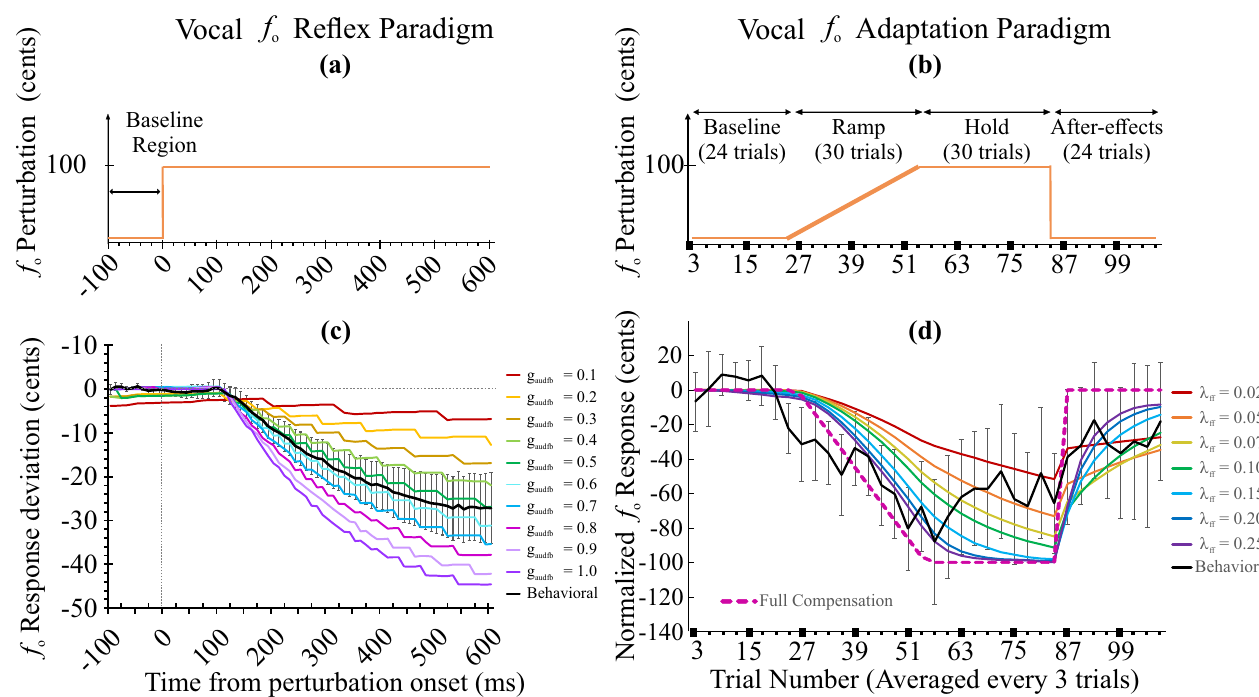
Fig 3. Simulation responses of LaDIVA compared with the mean group response (20 adults with typical speech) of the behavioral dataset. (a) Applied f o perturbation for a perturbed trial in the vocal f reflexive paradigm. (b) Vocal f perturbation across all 108 trials of the vocal f adaptive paradigm. (c) o o o Simulation response for vocal f reflexive paradigm. (d) Simulation response for vocal f adaptation paradigm. All simulations in panel (c) and (d) were o o conducted under initial laryngeal muscle activation settings (Case B: a CT = 0.169, a TA a TA = 0.175, and P s = 800 Pa). Group mean response of behavioral dataset in black with 95% CI error